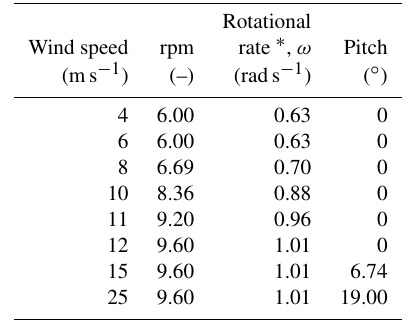
Table A1. Operational conditions for the simulations in the anal- ysis. For the compressible solver (ADflow), we use velocity, den- sity, and temperature as input parameters. ADflow then com- putes the complete thermodynamic conditions. The density is set to 1 . 225kgm − 3 , temperature to 15 ◦ C, and dynamic viscosity to 1 . 784 × 10 − 5 kgm − 1 s − 1